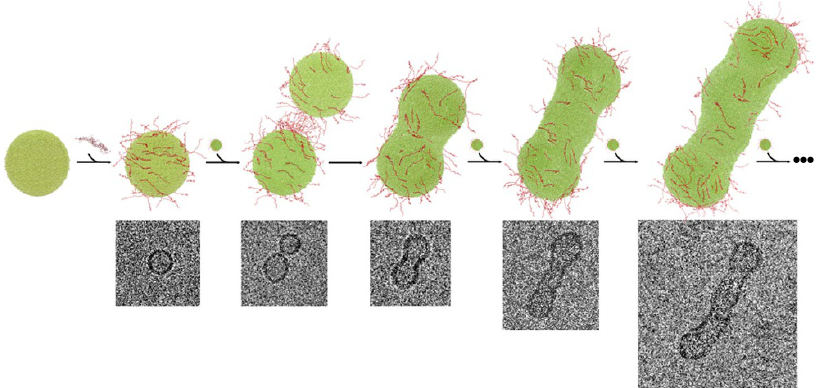
Figure 4 | Stepwise representation of SUV interactions and fusion promoted by a S. The scheme shows the stepwise mechanism of vesicles assembly as probed from images obtained in vitro by cryo-EM, which are also shown. Disordered cytoplasmatic a S (red) binds dynamically to the surface of SUVs (green), as described in this study. SUVs coated with a S assemble with fast kinetics as a consequence of the double-anchor mechanism promoted by the a S molecules decorating their surfaces. The tethered SUVs, which are initially assembled together in dimeric, trimeric, tetrameric and higher order states, eventually fuse to form larger vesicles. With the increasing size of the fused vesicle, we observed preferential fusion events at the termini of the aggregated vesicles. This observation can be explained by the higher affinity of a S for significantly curved membrane surfaces 19 , which increases the concentration of bound a S at the termini of the elongated vesicles thereby promoting a stronger double-anchor mechanism in these loci.